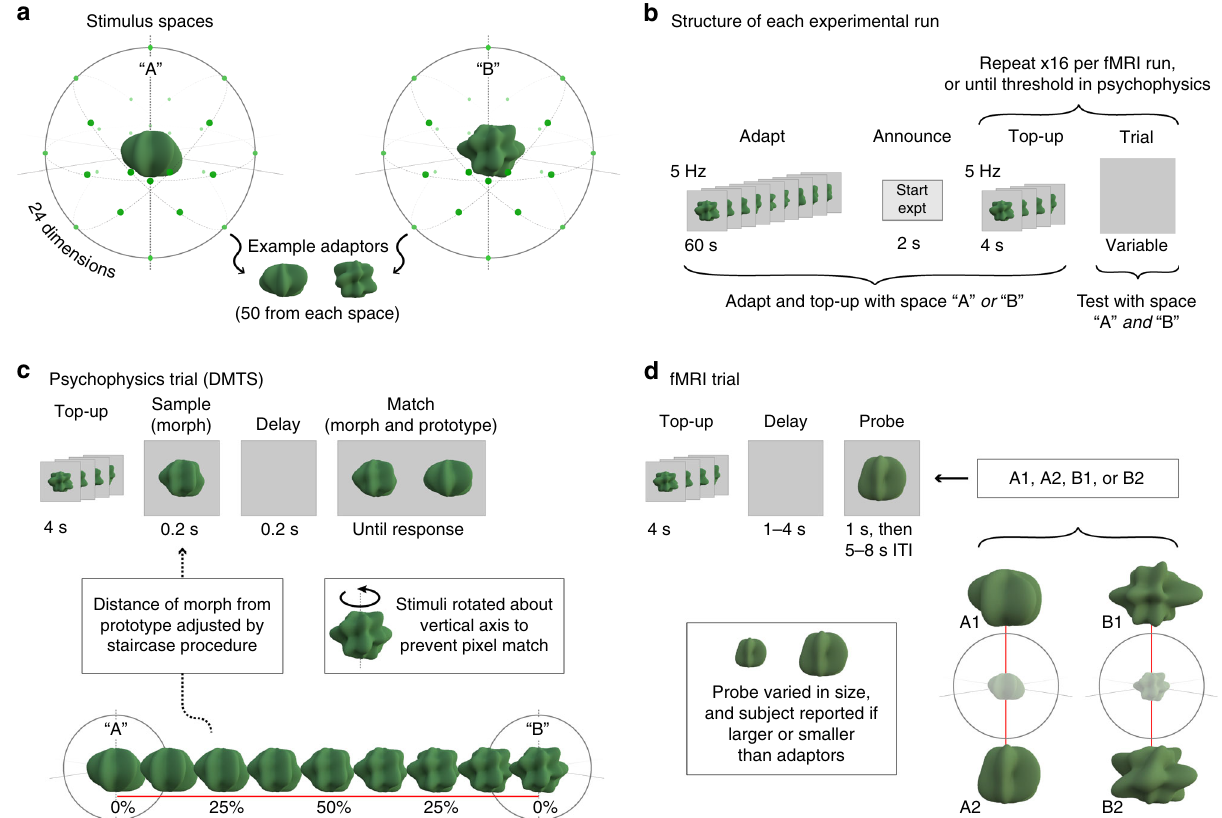
Fig. 1 Experimental design. a We sampled 3D shapes from a 24-dimensional, radial frequency stimulus space in which the dimensions were de fi ned by the frequencies, amplitudes, and phases of 8 sinusoids. Two visually distinct shapes from this space were chosen as prototypes A and B. For each prototype, 50 adaptor stimuli were generated in the multidimensional space by jittering the orientation and amplitude of the 8 sinusoidal components, producing two distinct shape classes. b In the beginning of each experimental run (for both psychophysics and fMRI experiments), subjects were presented with a series of shapes from one of the two shape classes for 60 s at a rate of 5 Hz (adapt phase). All trials began with a top-up adaptation period of 4 s at 5 Hz,